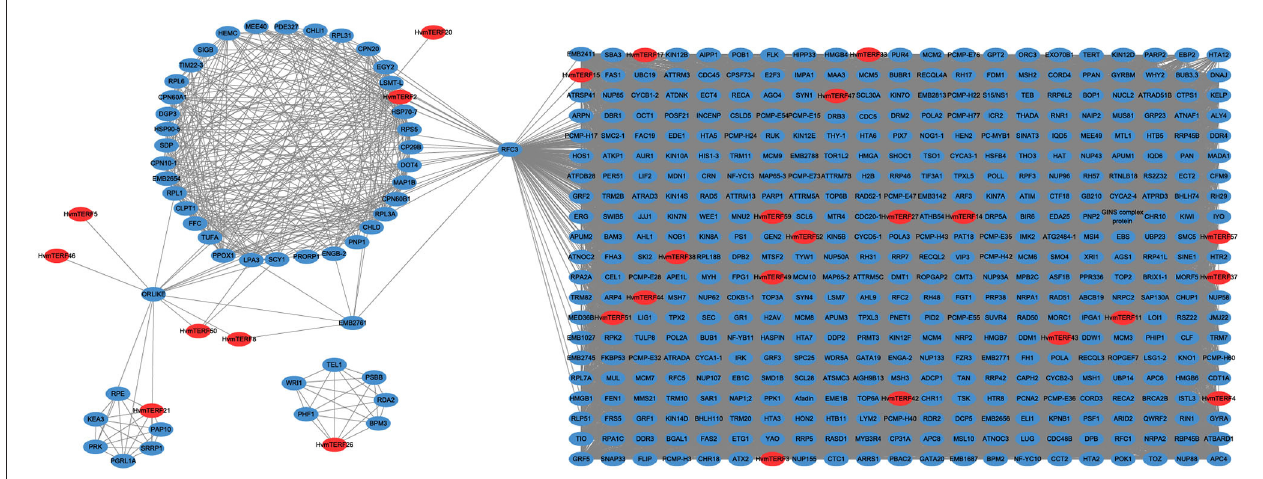
FIGURE 7 | The co-expression network analysis of HvmTERFs with other barley genes. Only annotated genes are